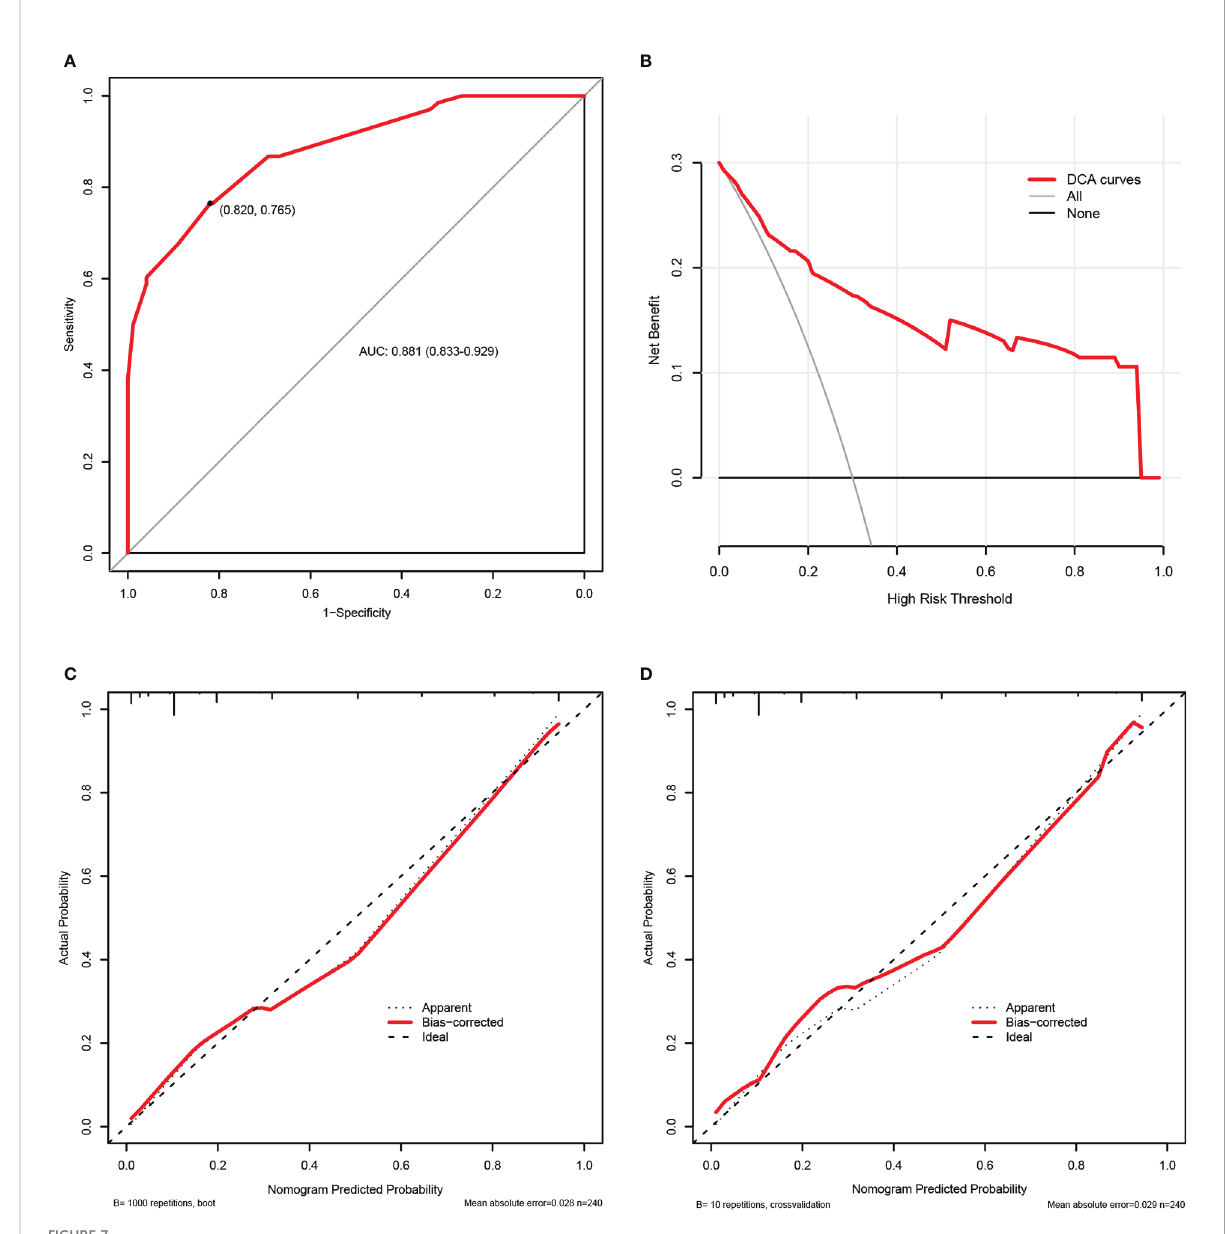
FIGURE 7 The internal validation of the prognosis nomogram according to bootstrap method and 10-fold cross validation. Receiver operating characteristic (ROC) curves of the prognosis nomogram (A) . Decision curve analysis (DCA) of the prognosis nomogram (B) . Calibration plots of the prognosis nomogram based on bootstrap method (C) and 10-fold cross validation (D)